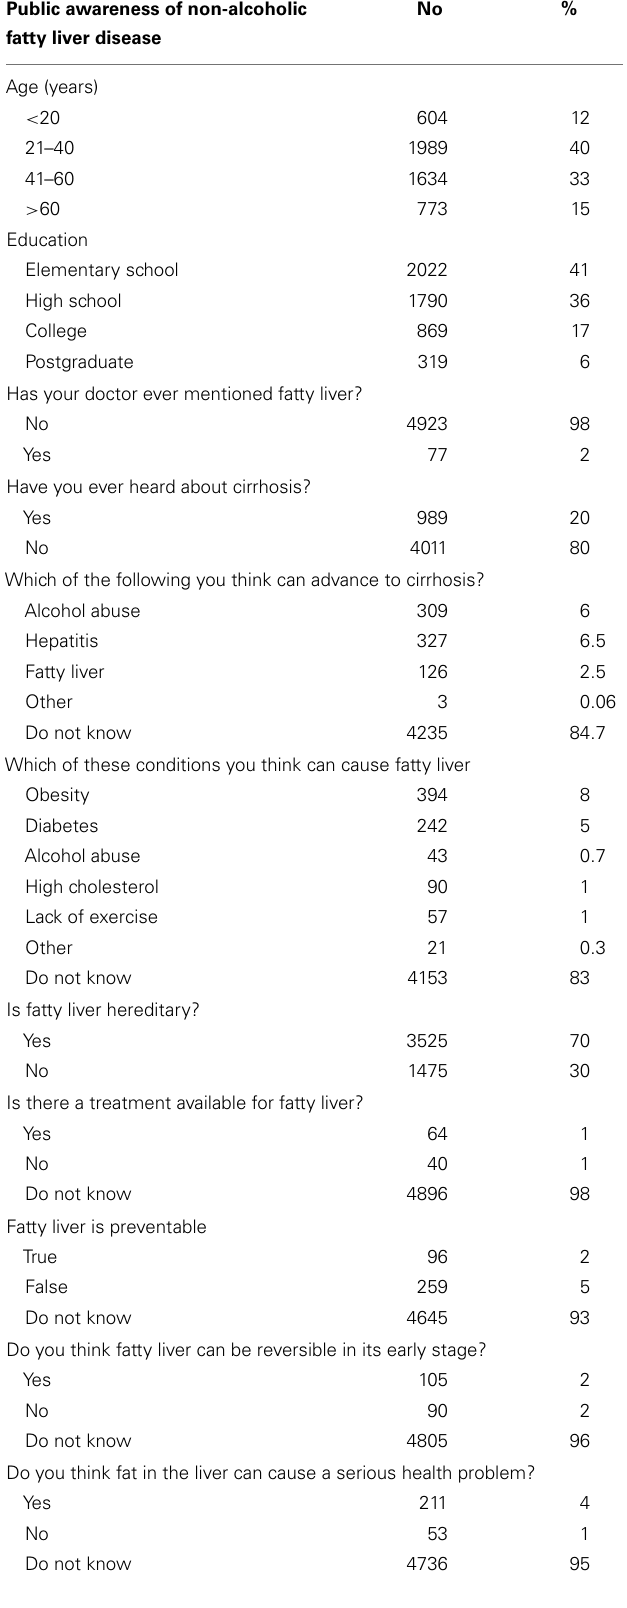
Table 1 | Selected survey